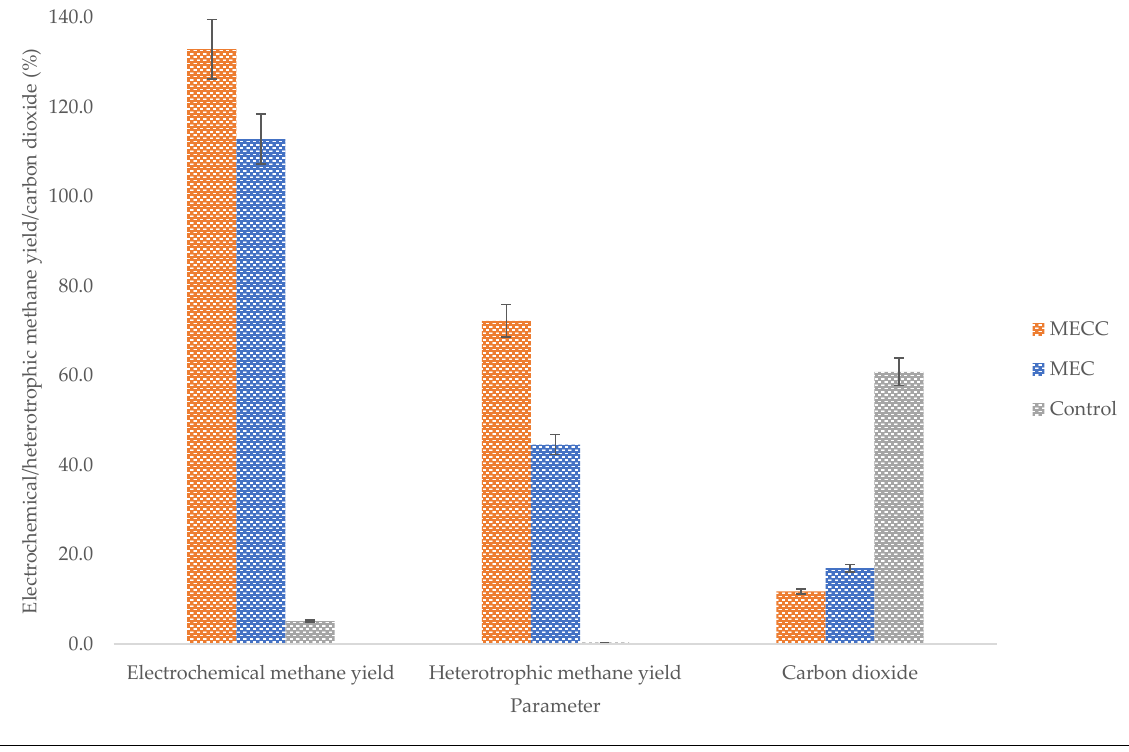
Figure 4. Electrochemical methane yield and heterotrophic methane yield with respect to carbon dioxide.